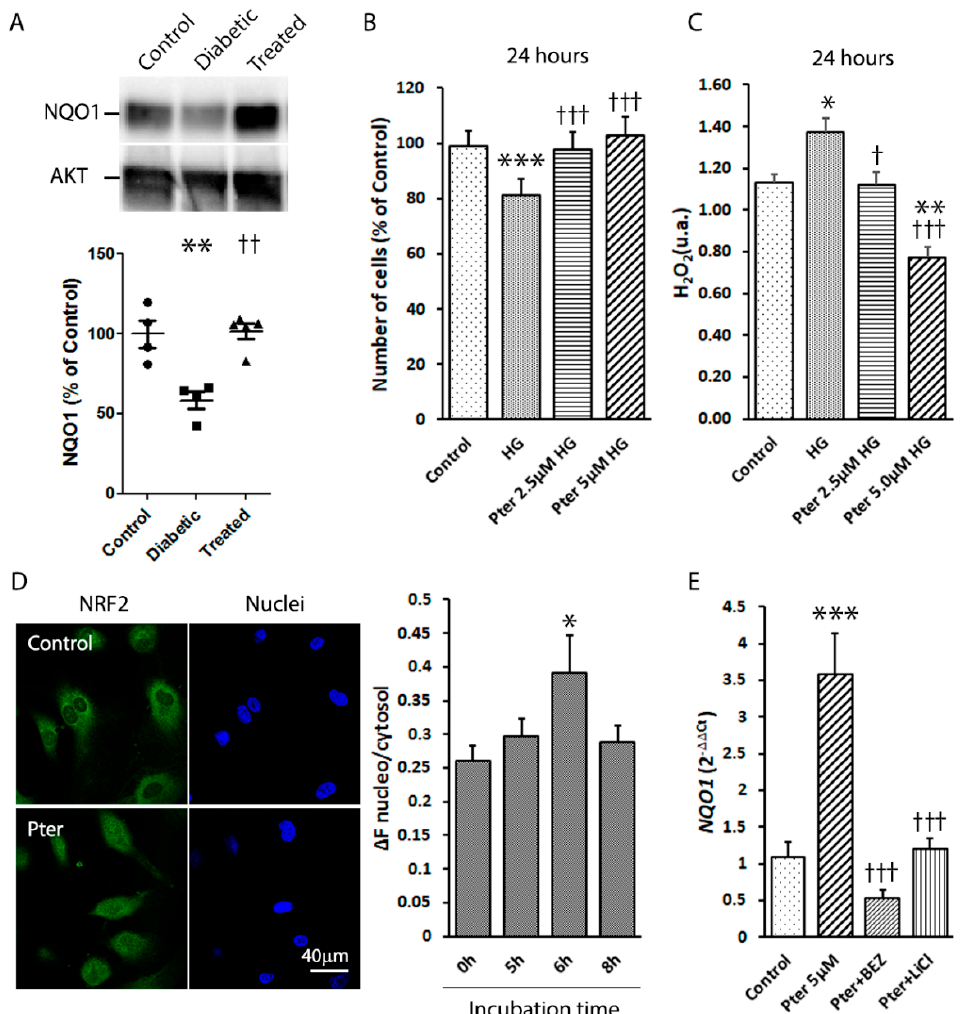
Figure 5. E ff ect of pterostilbene on NRF2 activation. ( A ) A Western blot was used to detect the expressions of NQO1 in retinas. Data are presented as mean ± SEM (at least n = 4 in each group). A one-way ANOVA and a Newman-Keuls multiple comparison test were used. ** p < 0.01; versus the control group; †† p < 0.01 versus the diabetic group. ( B ) HREC were treated for 24 h with Pter (2.5 µ M and 5 µ M) at high (30 mM) glucose concentrations. Statistical analyses were performed by a one-way ANOVA, followed by Tukey’s test. *** p < 0.001 versus the control group. ††† p < 0.001 versus the high glucose group. ( C ) Hydrogen peroxide was determined in HREC medium after 24 h of incubation with Pter (2.5 µ M and 5 µ M) at high (30mM) glucose concentrations. An ANOVA followed by Tukey’s post hoc test, was used to assess significant di ff erences between the experimental conditions * p < 0.05; ** p < 0.01; versus the control group. † p < 0.05; ††† p < 0.001 versus the high glucose group. ( D ) NRF2 translocation was detected by confocal microscopy in HREC. Cells were incubated with Pter 5 µ M and fixed with 4% paraformaldehyde at 0, 5, 6 and 8 h. NRF2 was detected by immunocytochemistry and NRF2 translocation was evaluated by the ImageJ software. A representative image after 6 h of incubation with Pter. Data were analysed by a one-way ANOVA, followed by Tukey’s test. * p < 0.05 versus the control group (0 h) ( E ) HREC were incubated in the presence of DMSO (control), Pter 5 µ M, Pter (5 uM) + BEZ235 (10 nM), and Pter (5 uM) + LiCl (20 mM) for 24 h. The RNA levels of NQO1 were determined by qRT-PCR normalised to the β -Actin mRNA levels. Data are presented as mean ± SEM (at least n = 3 in each group). Di ff erences among groups were assessed by a one-way ANOVA, followed by Tukey’s test. *** p < 0.001 versus the control group. ††† p < 0.001 versus the Pter group.